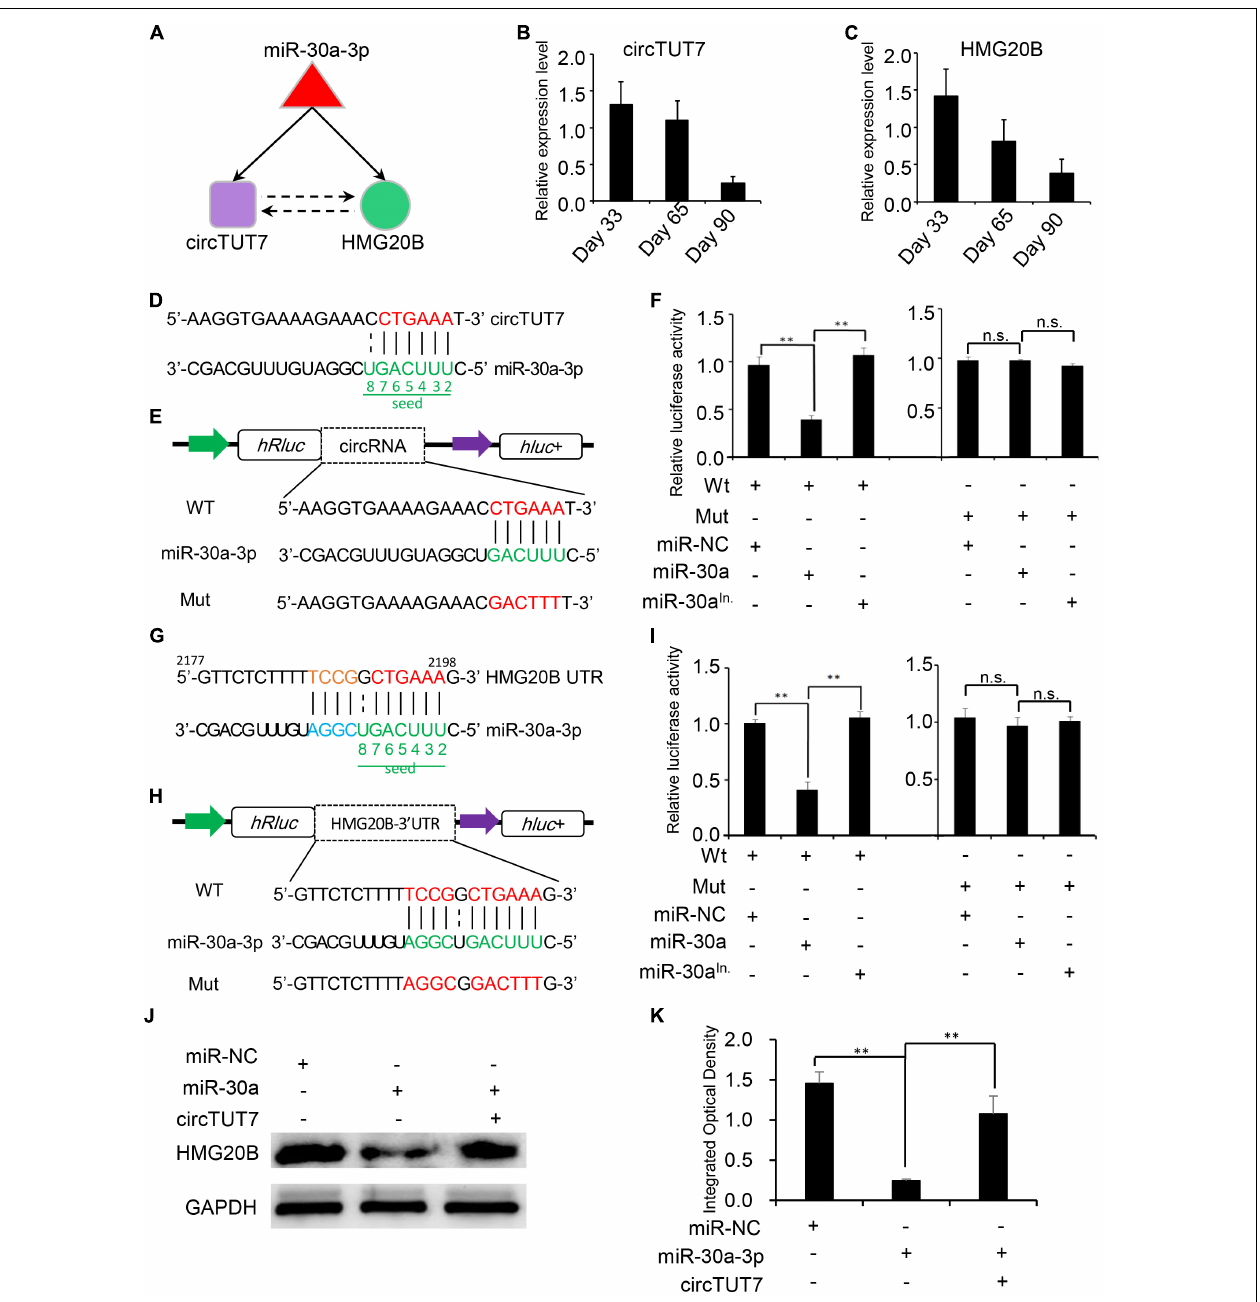
FIGURE 5 | Experimental validation of circRNA-mRNA-miRNA regulatory circuitry. (A) Illustration of a three nodes circuitry including miRNA-30a-3p, circTUT7, and HMG20B. The purple node represents circRNAs; green node represents key genes related to myogenesis; the red node represents miRNA. RT-qPCR shows the relative expression level of circTUT7 (B) and HMG20B (C) during embryonic muscle development. (D) Predicted miR-30a-3p binding site on circTUT7. (E) The design of luciferase reporter. WT, the WT sequence of circTUT7 contains miR-30a-3p binding site; Mut, the sequence of circTUT7 with mutation in miR-30a-3p binding site. (F) PK15 cells were co-transfected with wild-type (WT) or mutant (MUT) luciferase reporters of circTUT7 with miR-30a-3p mimics, mimics negative control (NC) or miRNA inhibitors. The relative levels of firefly luminescence normalized to Renilla luminescence are plotted. Error bars represent SD ( n = 3). (G) Predicted miR-30a-3p binding site on HMG20B-3’UTR. (H) The design of luciferase reporter. WT, the WT sequence of HMG20B-3’UTR contains miR-30a-3p binding site; Mut, the sequence of HMG20B-3’UTR with mutation in miR-30a-3p binding site. (I) PK15 cells were co-transfected with wild-type (WT) or mutant (MUT) luciferase reporters of HMG20B with miR-30a-3p mimics, mimics NC or miRNA inhibitors. The relative levels of firefly luminescence normalized to Renilla luminescence are plotted. Error bars represent SD ( n = 3). (J) Expression of HMG20B protein in PFFs infected with miRNA mimics, mimics NC and circRNA overexpression vector. (K) Results of western blotting were quantified by ImageJ (v1.45). The relative levels of HMG20B protein are plotted, error bars represent SD ( n = 3). ∗∗ P < 0.01.